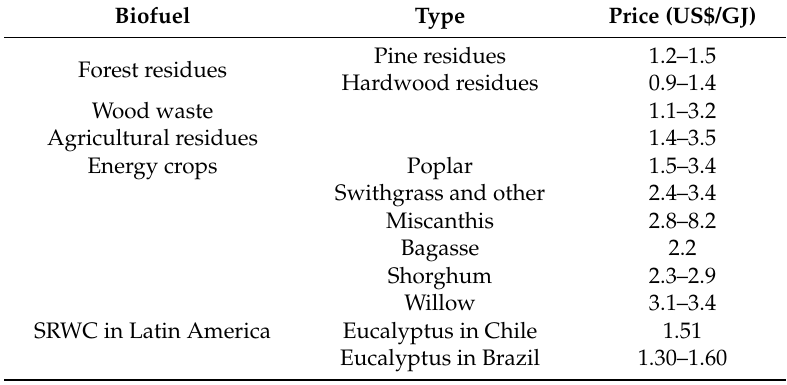
Table 4. Biomass feedstock characteristics and cost in the United States in